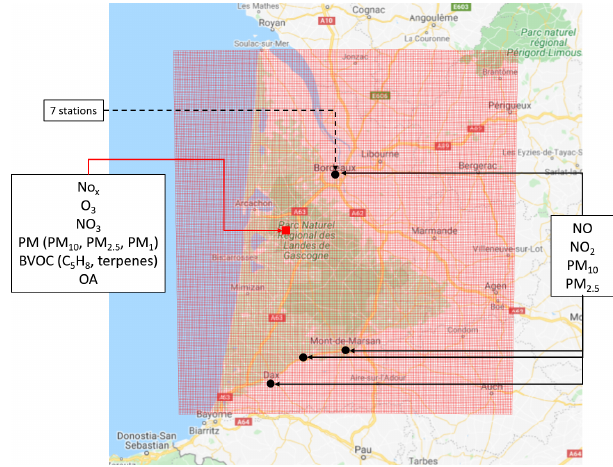
Figure 1. Measurements and monitoring stations in the Landes region and the high-resolution simulation domain (horizontal res- olution of 1km). Black dots represent where the air quality sta- tions used are located, and the red circle shows the main measure- ment site at Salles-Bilos. Note that the northern point located in the city of Bordeaux includes seven stations (not shown separately because of their proximity). © OpenStreetMap contributors